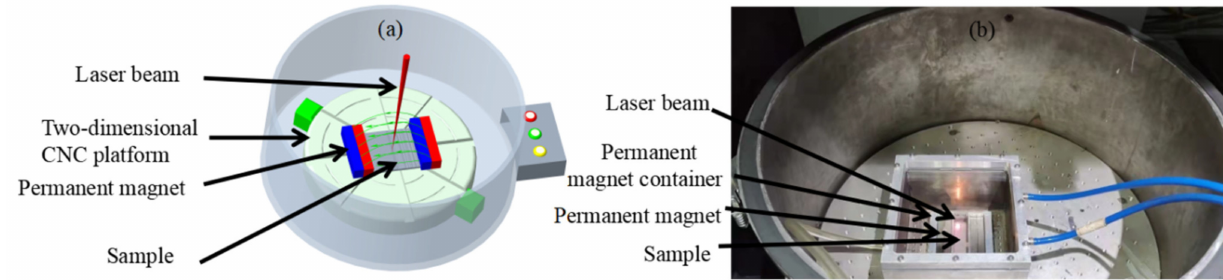
Figure 2. Test principle and installation diagram of magnetic field-assisted laser polishing: ( a ) principle of magnetic field test device; ( b ) magnetic field auxiliary test device.